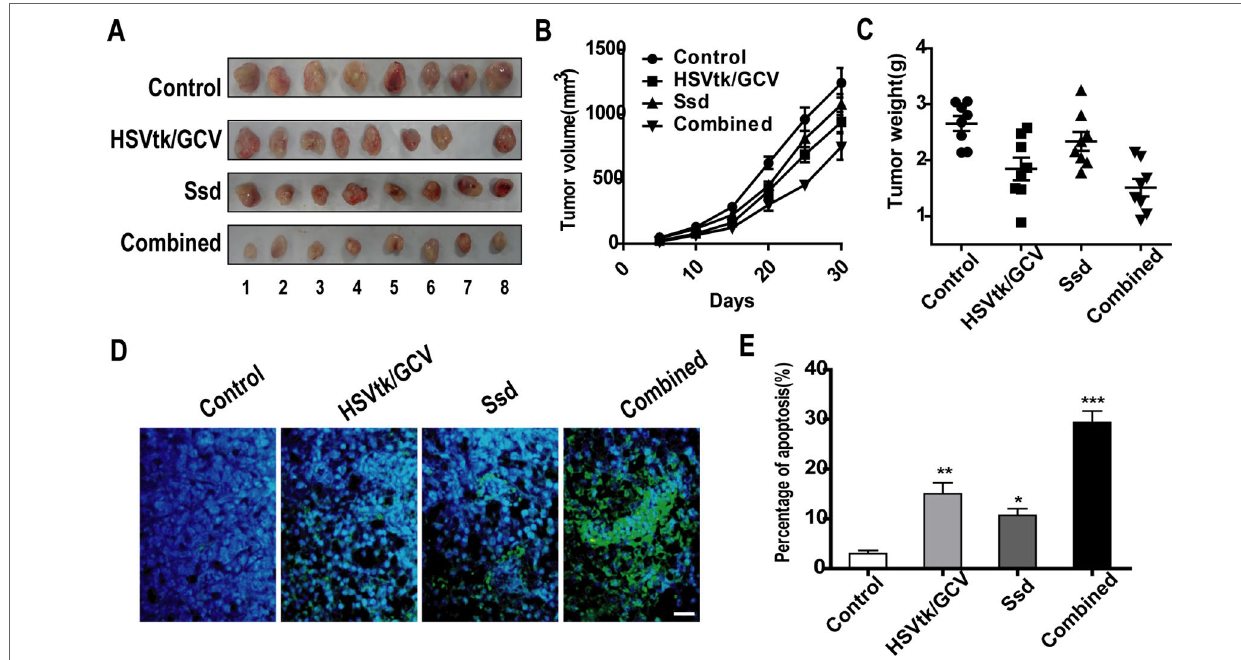
FIGURE 6 | Saikosaponin-d (Ssd) inhibits tumor growth and increases the sensitivity of hepatocellular carcinoma (HCC) cells to herpes simplex virus thymidine kinase/ganciclovir (HSVtk/GCV) in vivo . BALB/c nude mice were inoculated with HSVtk/Hep3B cells and subsequently treated with vehicle, Ssd, GCV, or a combination of Ssd and GCV. (A) Subcutaneous tumors were dissected from nude mice and photographed. (B) Tumor volumes were measured every 3 days over a 30-day period. (C) Tumors were weighted immediately after dissection from nude mice. (D) Apoptosis in tumor xenograft sections was detected by TUNEL staining (scale bar, 25 µm). (E) Quantification of apoptosis in tumor sections. Data are expressed as means ± SD (n = 3); * P < 0.05, ** P < 0.01, and *** P < 0.001 when compared with the control (Student’s t